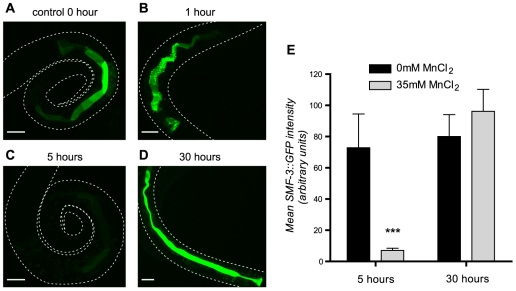
SMF-3::GFP is down-regulated upon Mn exposure.SMF-3::GFP signal is strongly detected at the apical plasma membrane prior Mn treatment (A). After 1 hour of exposure to 35 mM MnCl2, SMF-3-GFP localizes to sub-apical vesicular compartments (B). C, SMF-3::GFP signal is strongly decreased at 5 hours post-treatment. After a day of recovery, SMF-3::GFP expression returns to control levels and SMF-3::GFP relocates to the apical plasma membrane (D). Scale bars are 5 µm. (E) quantification of apical plasma-membrane SMF-3::GFP in the whole intestine after 5 and 30 h of exposure in control and treated animals. While # designate significant differences between genetic backgrounds exposed to the same manganese dose, * indicate significant differences between exposure doses within the same C. elegans strain: #/* p<0.05. ##/** p<0.01, ###/p<0.001.